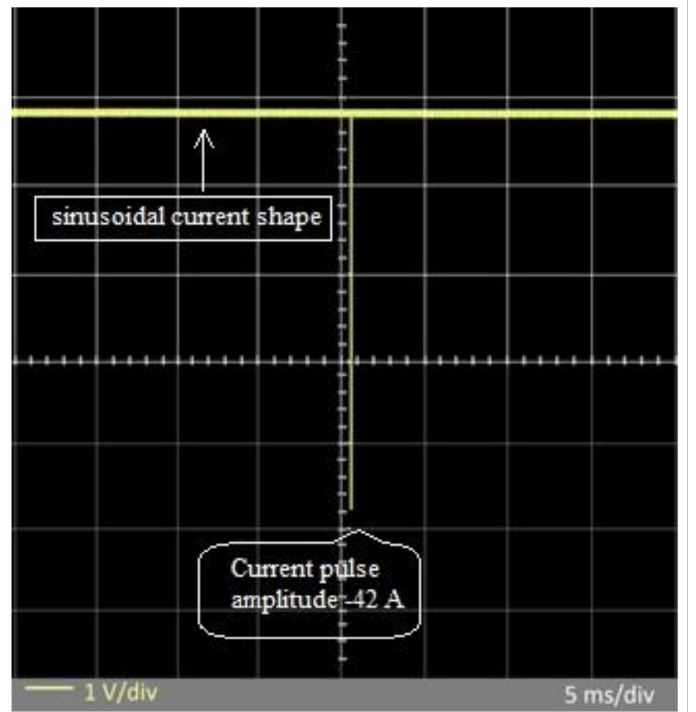
Figure 17. Current waveform in a photovoltaic system disturbed by a 1.2/50 µ s voltage surge with negative